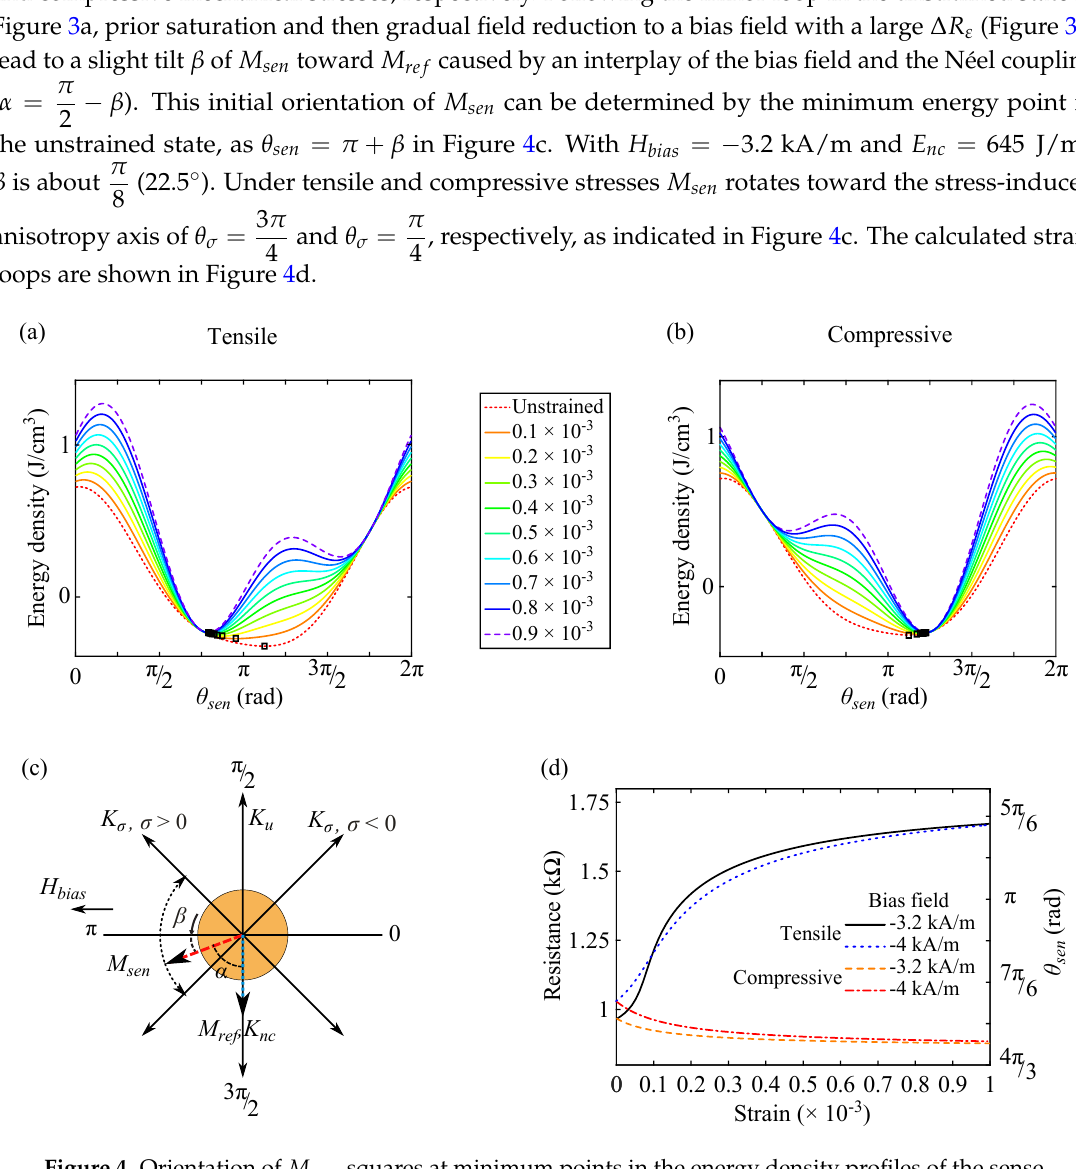
Figure 4. Orientation of M sen , squares at minimum points in the energy density profiles of the sense layer at − 3.2 kA/m ( − 40Oe) under ( a ) tensile and ( b ) compressive stresses; ( c ) Configuration of physical quantities under tensile and compressive stresses; ( d ) Calculated strain loops at bias fields of − 3.2 kA/m and − 4 kA/m ( − 50Oe). The right y-axis indicates the corresponding orientation of M sen extracted from the energy density profiles. Tensile (compressive) stress increases (reduces) the angle α resulting in a rise (drop) in the tunnel